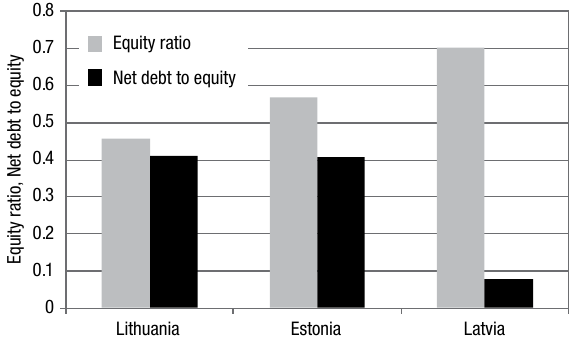
Fig. 1. Debt level of Baltic companies (FY